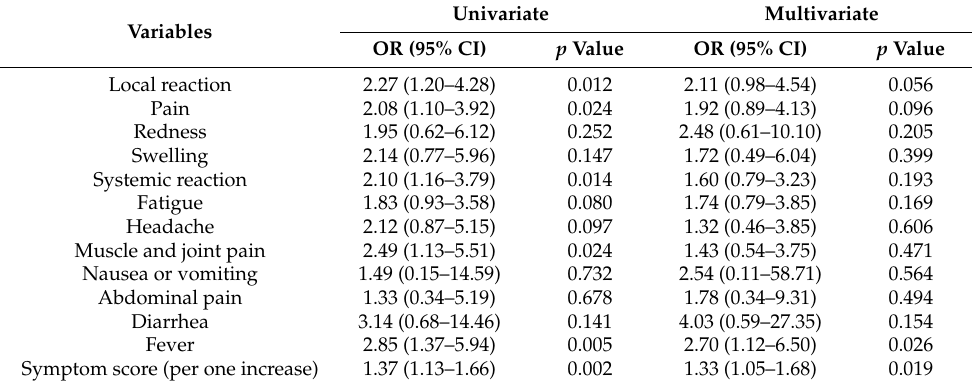
Table 4. Solicited local and systemic reactions as determinants of anti-spike IgG antibody response to SARS-CoV-2